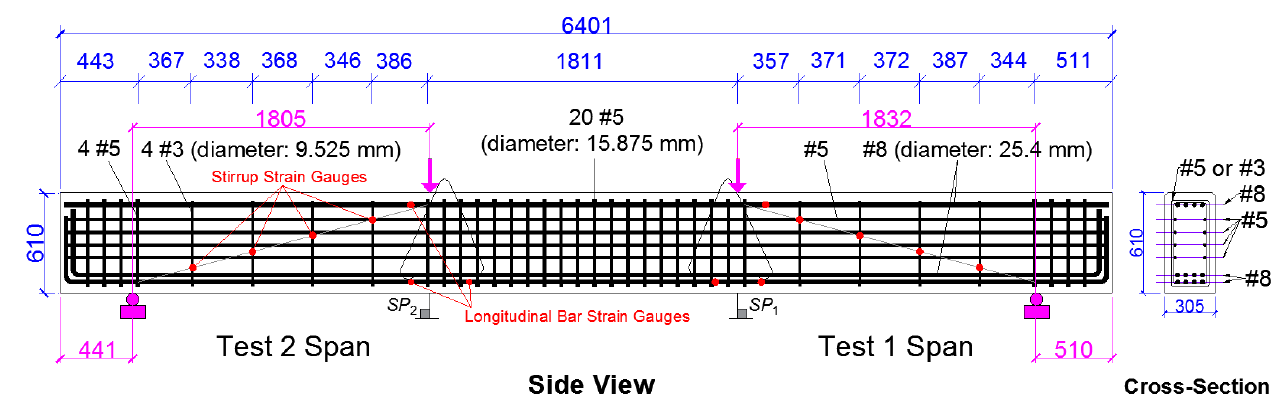
Figure 4. As built dimensions of the full-scale beam, loading and support locations and instrumentation (all dimensions are in mm).